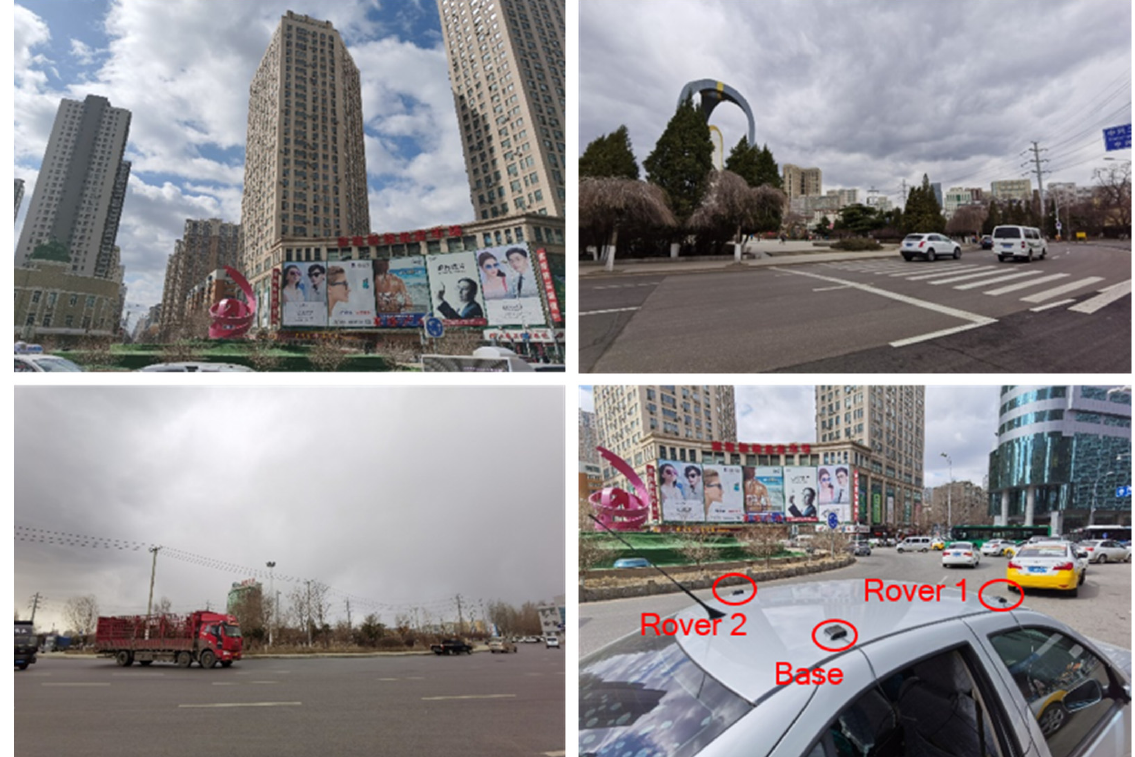
Figure 7. Dynamic experiment. Top left panel: heavily degraded (Taiyuan roundabout). Top right panel: lightly degraded (Peacefully Plaza). Bottom left panel: open-sky (Development Avenue turntable). Bottom right panel: the antennae configuration. Recorded with Ublox M8T, patch antenna on 19 March